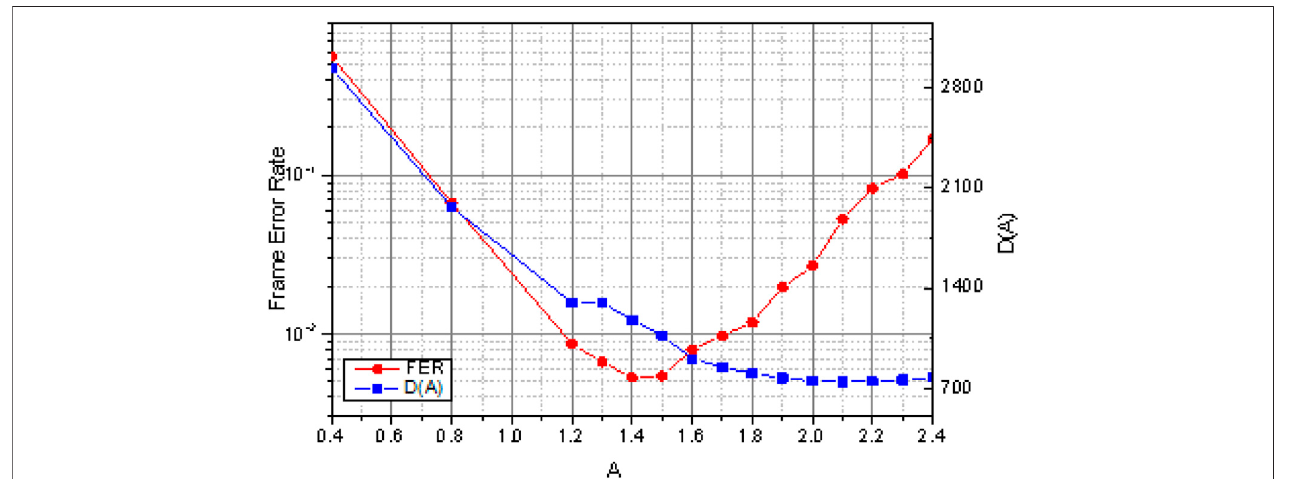
FIGURE 8 | Simulation of BER and corresponding mean square error of 2-bit uniform quantization.